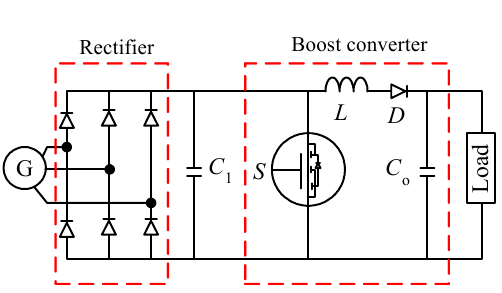
Figure 6. Configuration on modeling of power generation system. C 1 : Linking capacitor; C 0 : Output